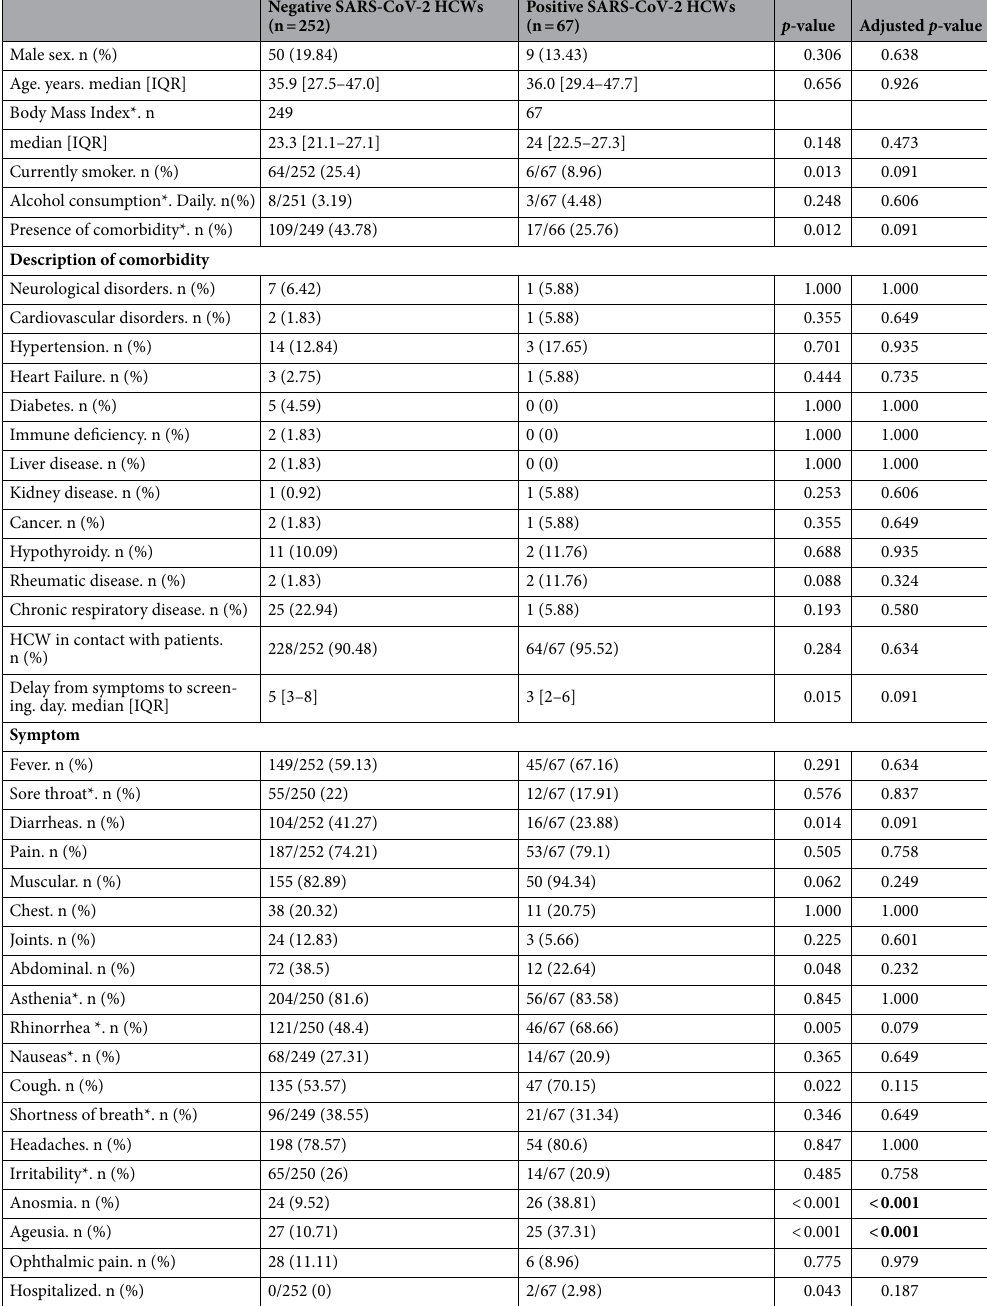
Table 1. Demographic and clinical characteristics of health-care workers (HCWs) exhibiting a negative or a positive RT-PCR test for SARS-CoV-2. *Missing